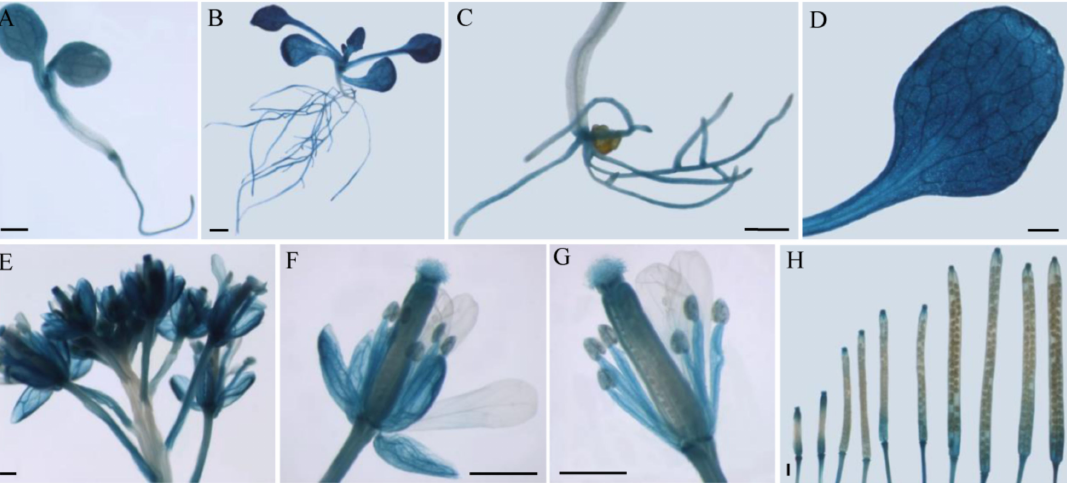
Figure 2. Spatial expression patterns of CsSWEET2 in transgenic Arabidopsis plants. ( A ) Seven-day- old seedling. ( B , C ) Two-week-old seedling. ( D ) Rosette leaf. ( E ) Inflorescence. ( F , G ) Flowers at higher magnification showing β -glucuronidase (GUS) staining in the sepals ( F ), filaments ( G ), and pistils ( F , G ). ( H ) Siliques at different stages. Scale bars = 1 mm.